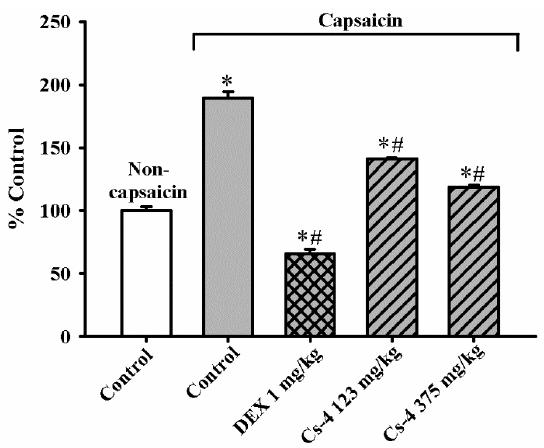
Figure 8. The effect of Cs-4 on the plasma IgE levels in capsaicin-challenged rats. Data were expressed as the control percent of noncapsaicin rats, with the control value being 16.9 ± 0.47 ng/mL. Each bar represents the mean ± S.E.M., with n = 8. * Significantly different from the noncapsaicin control group. # Significantly different from the capsaicin control group.